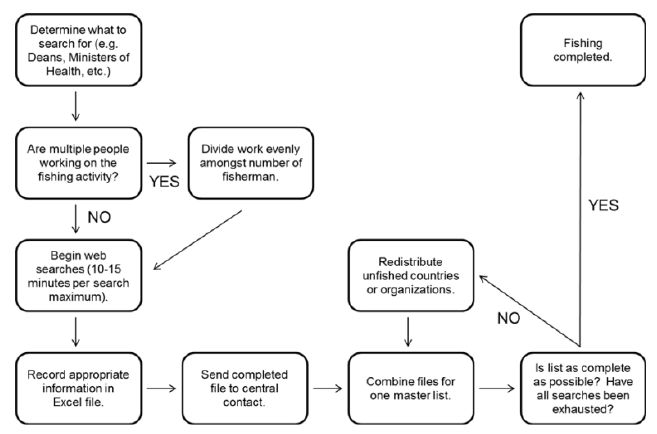
Figure 1. Flow chart depicting fishing